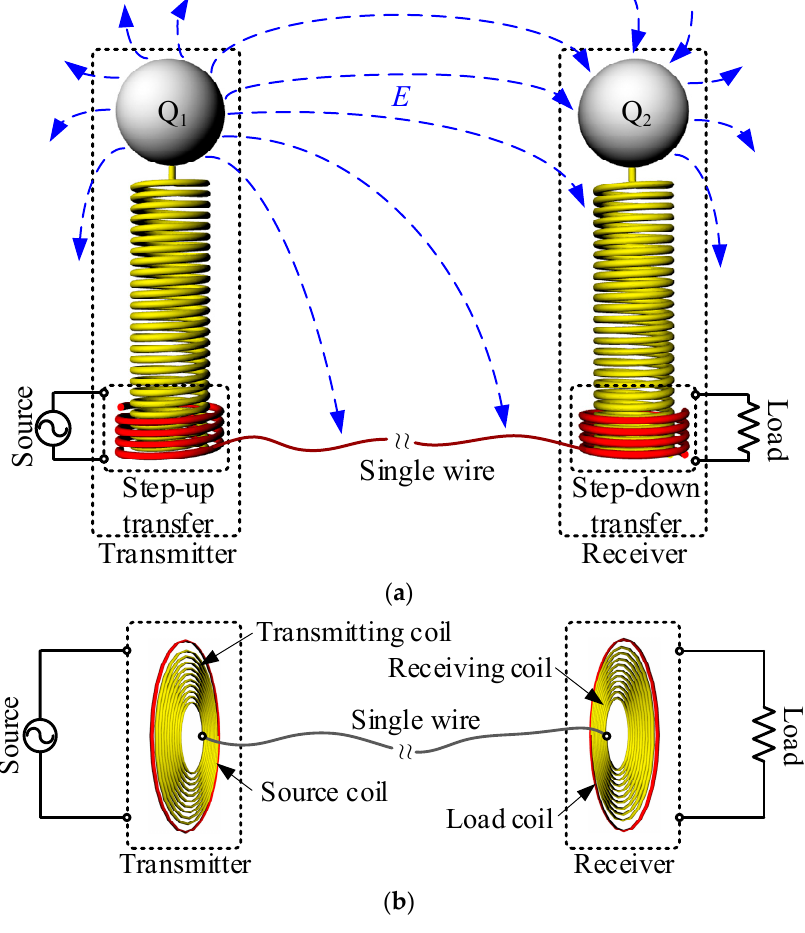
Figure 1. Structures of single-wire power transfer systems ( a ) evolved from Tesla’s wireless power transfer (WPT) system and ( b ) improved in this paper.